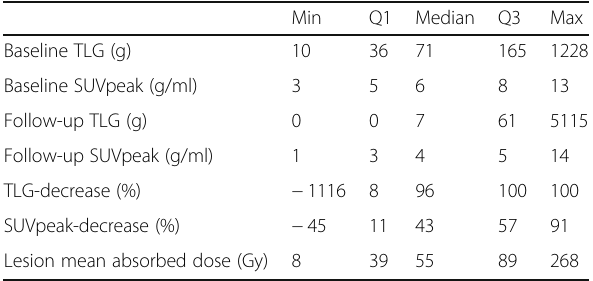
Table 2 Characteristics of